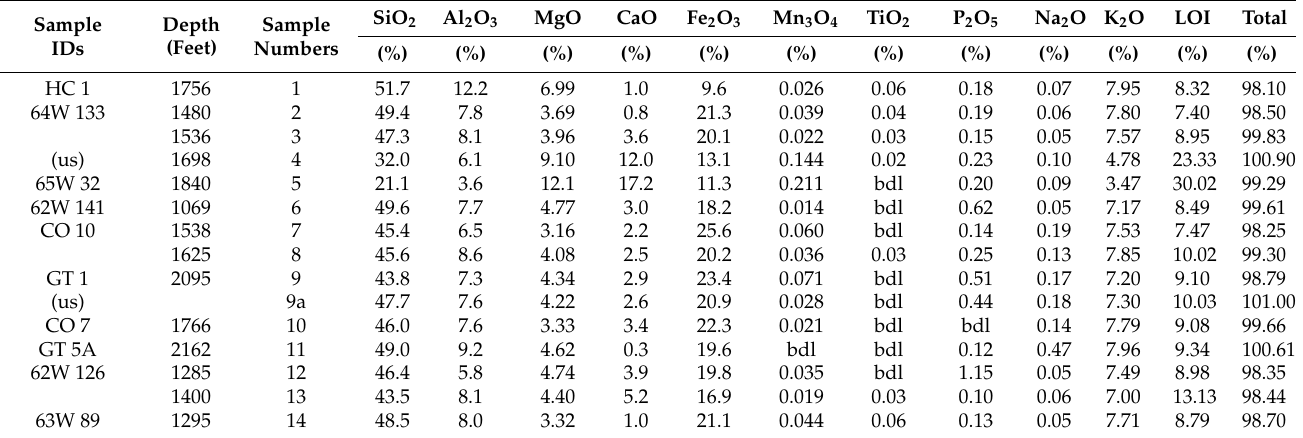
Table 2. Major elemental compositions of the glauconite-rich pellets studied